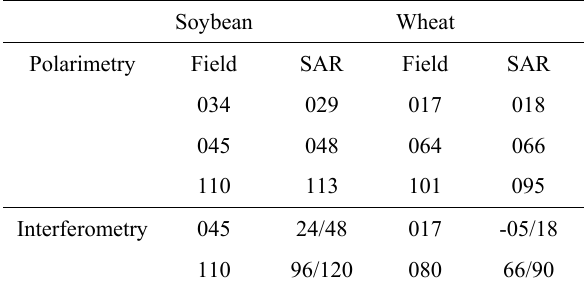
Table 4. DAS SAR data and field for soybean and